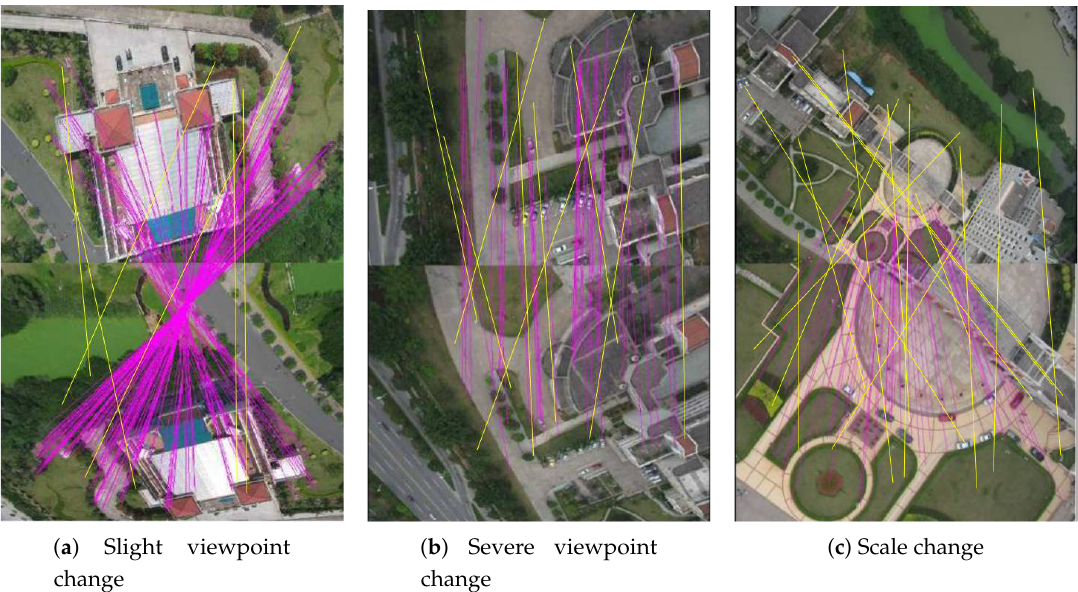
Figure 1. The inliers and the outliers of Scale Invariant Feature Transform (SIFT) feature matching results of Unmanned Aerial Vehicle (UAV) aerial images under different scenes, where red lines and yellow lines denote the correct and the wrong matches,